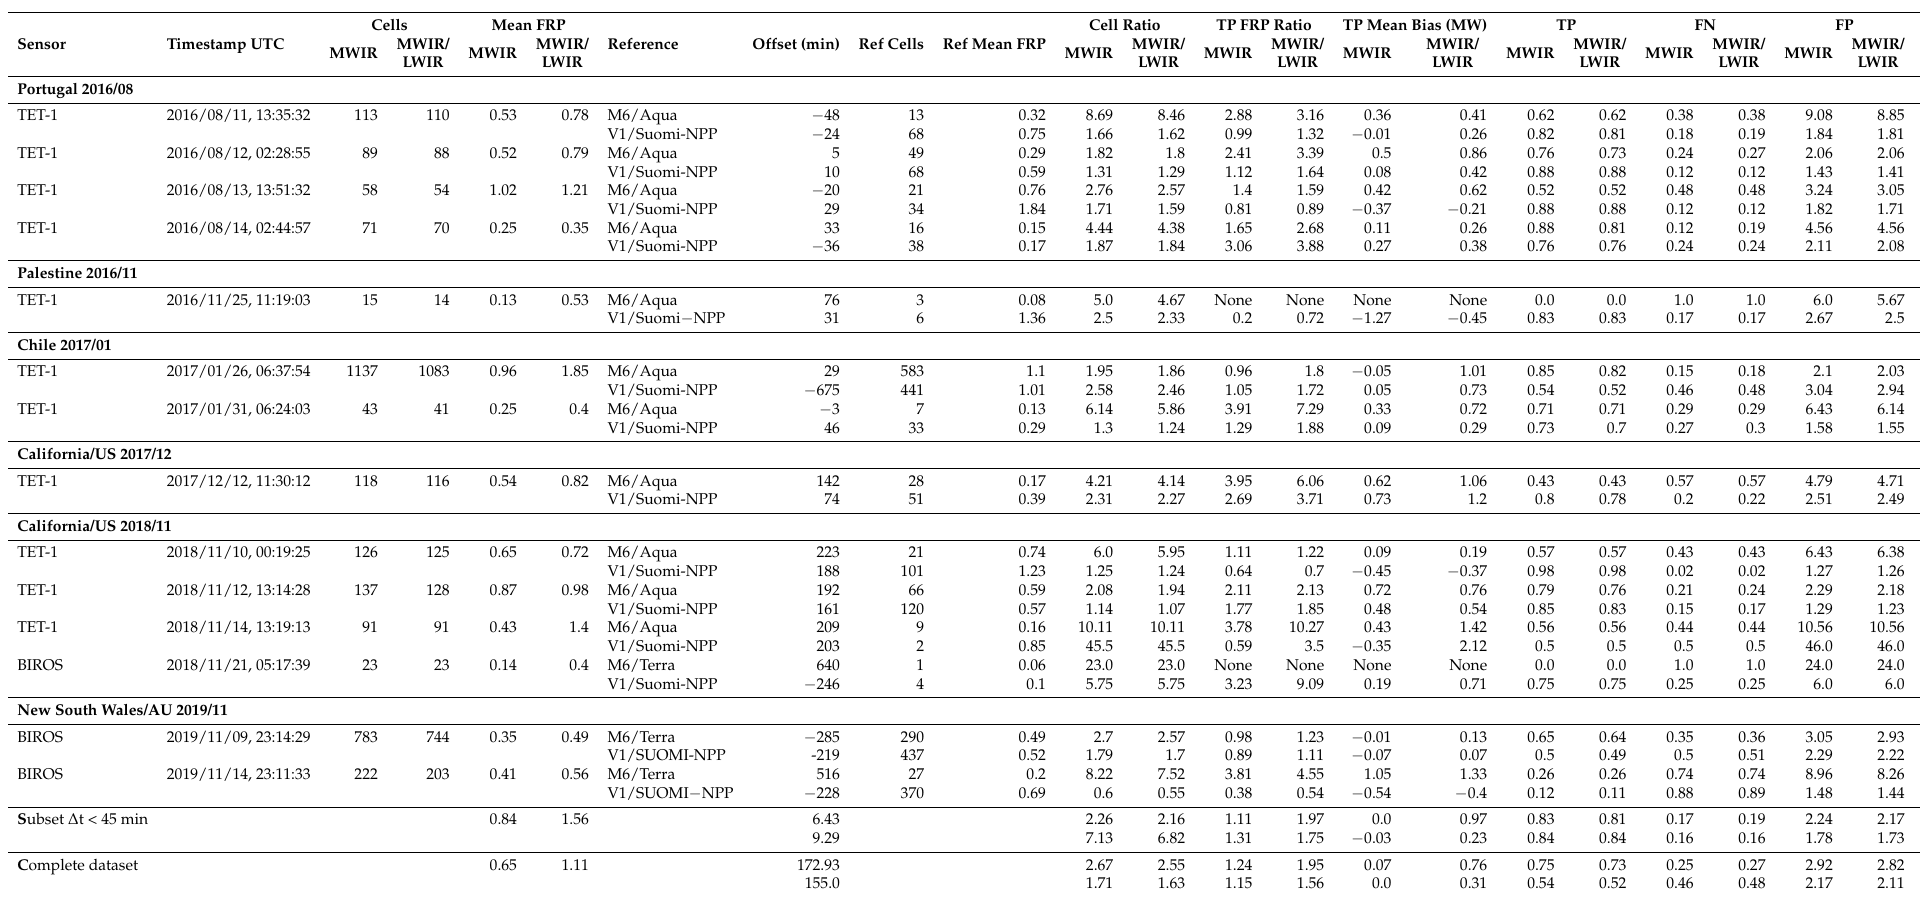
Table A1. Inter-comparison of DLR FireBIRD and NASA MODIS/VIIRS active fire results. The values in the two bottom rows, named subset and complete dataset, are derived from all detected fires in all overpasses, and do not represent average values of the overpasses listed above. The abbreviation TP refers to true positives, FN and FP refer to false negatives and false positives,